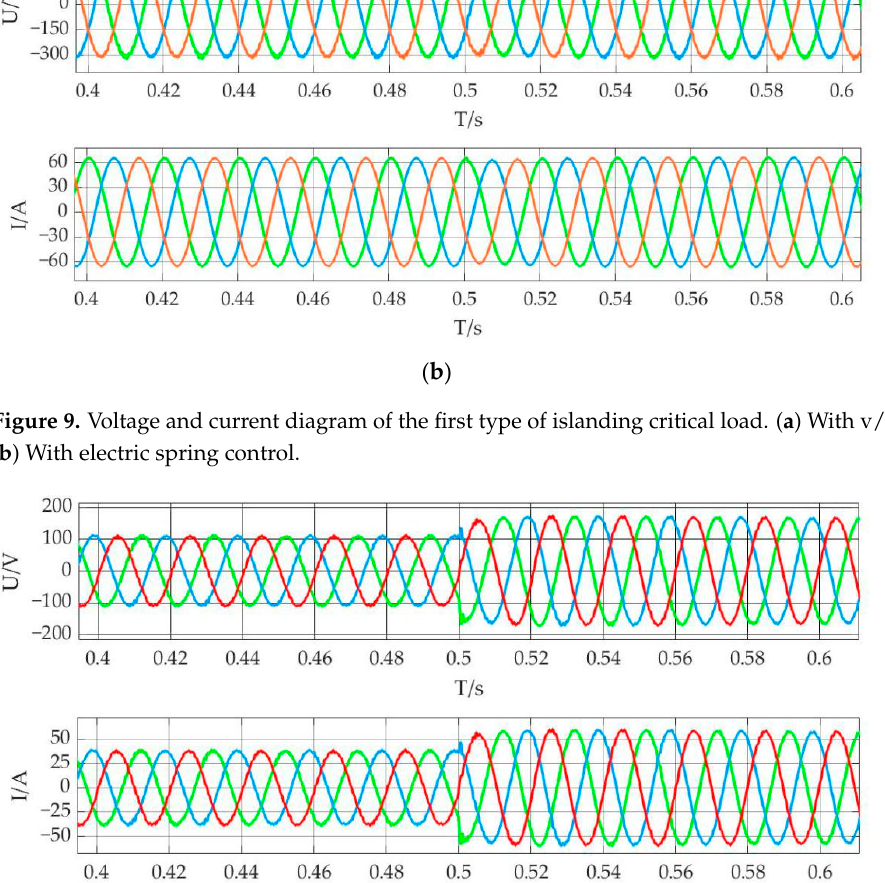
( b ) Figure 11. Critical load voltage curve. ( a ) With v/F control. ( b ) With electric spring control. 5.2. Simulation Analysis of the Second Kind of Unplanned Island When connected to the grid in these circumstances, the microgrid not only meets the power supply demand of the load on the AC bus, but also supplies power to the large power grid. When the large power grid suddenly goes offline, the microgrid solely sup- plies power to the load and no longer transmits energy to the distribution network. At this point, all of the energy in the distribution network flows to the AC bus, resulting in AC bus power overflow and a rapid rise in the voltage drop of essential loads, which will eventually revert to normal. When the ES is connected, the abrupt rise of the voltage in critical load causes the electric spring to reverse action and reduce the voltage in reverse, ensuring the critical load voltage is stable. The voltage and current on the critical load are shown in Figure 12.